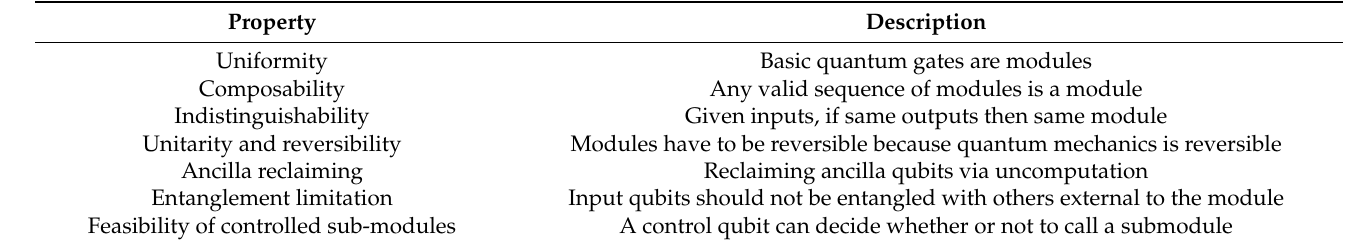
Table 1. Summary of rules for building up quantum